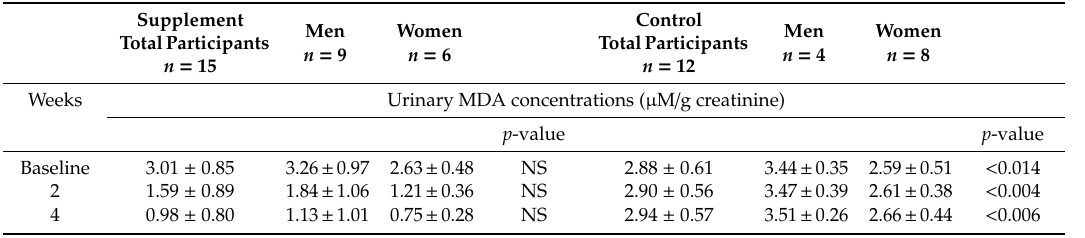
Table 5. Urinary MDA concentrations in men, women, and total participants before, during, and after 4 weeks of supplementation.